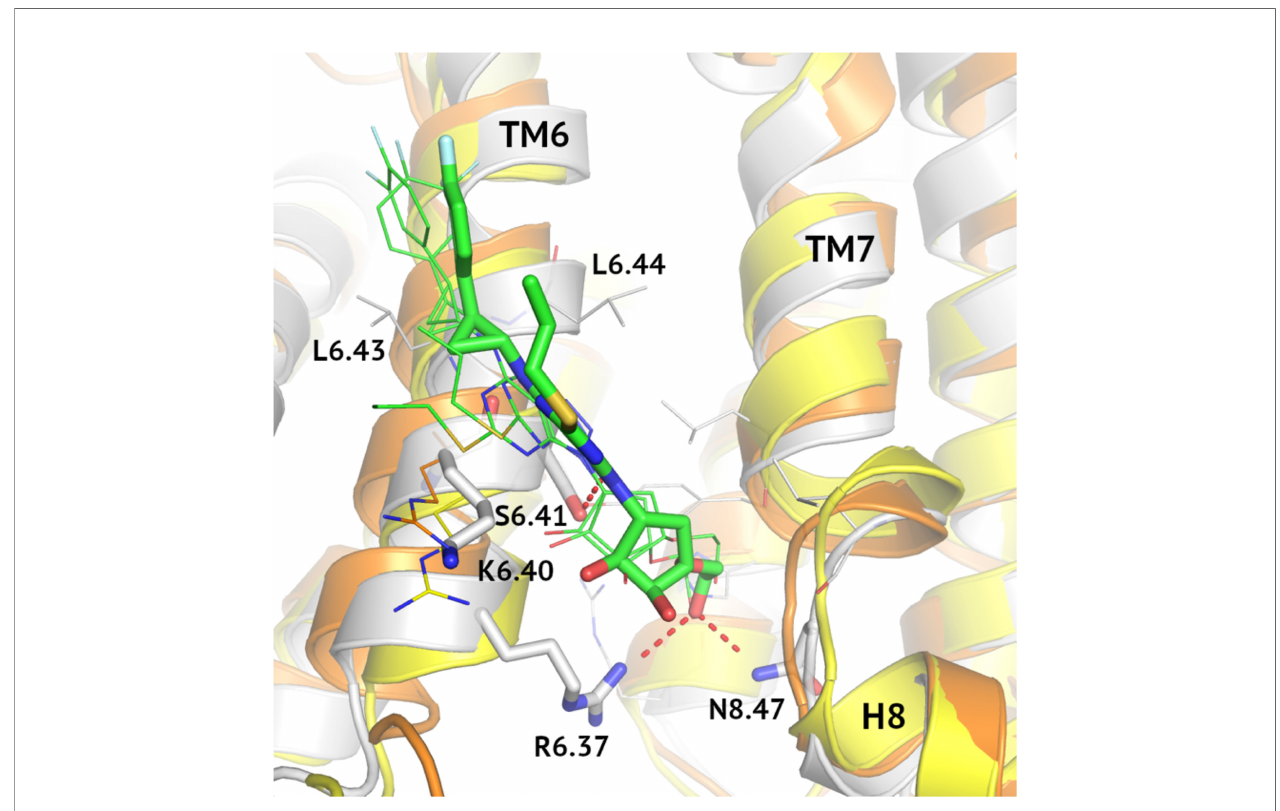
FIGURE 6 | MD-re fi ned allosteric binding modes of ticagrelor to VPAC1/VPAC2/PAC1. MD simulations of VPAC1/VPAC2/PAC1 complexes demonstrated the impact of the R6.40/K6.40 mutation in the NAM-binding region on receptor interactions with ticagrelor (green). The VPAC2-ticagrelor complex was shown in grey, VPAC1-ticagrelor – in orange, and PAC1-ticagrelor – in yellow. Hydrogen bonds in the VPAC2-ticagrelor complex were marked in red and ticagrelor was depicted with sticks. Here, only R6.40/K6.40 were shown in detail in all three receptors because other binding site residues were the